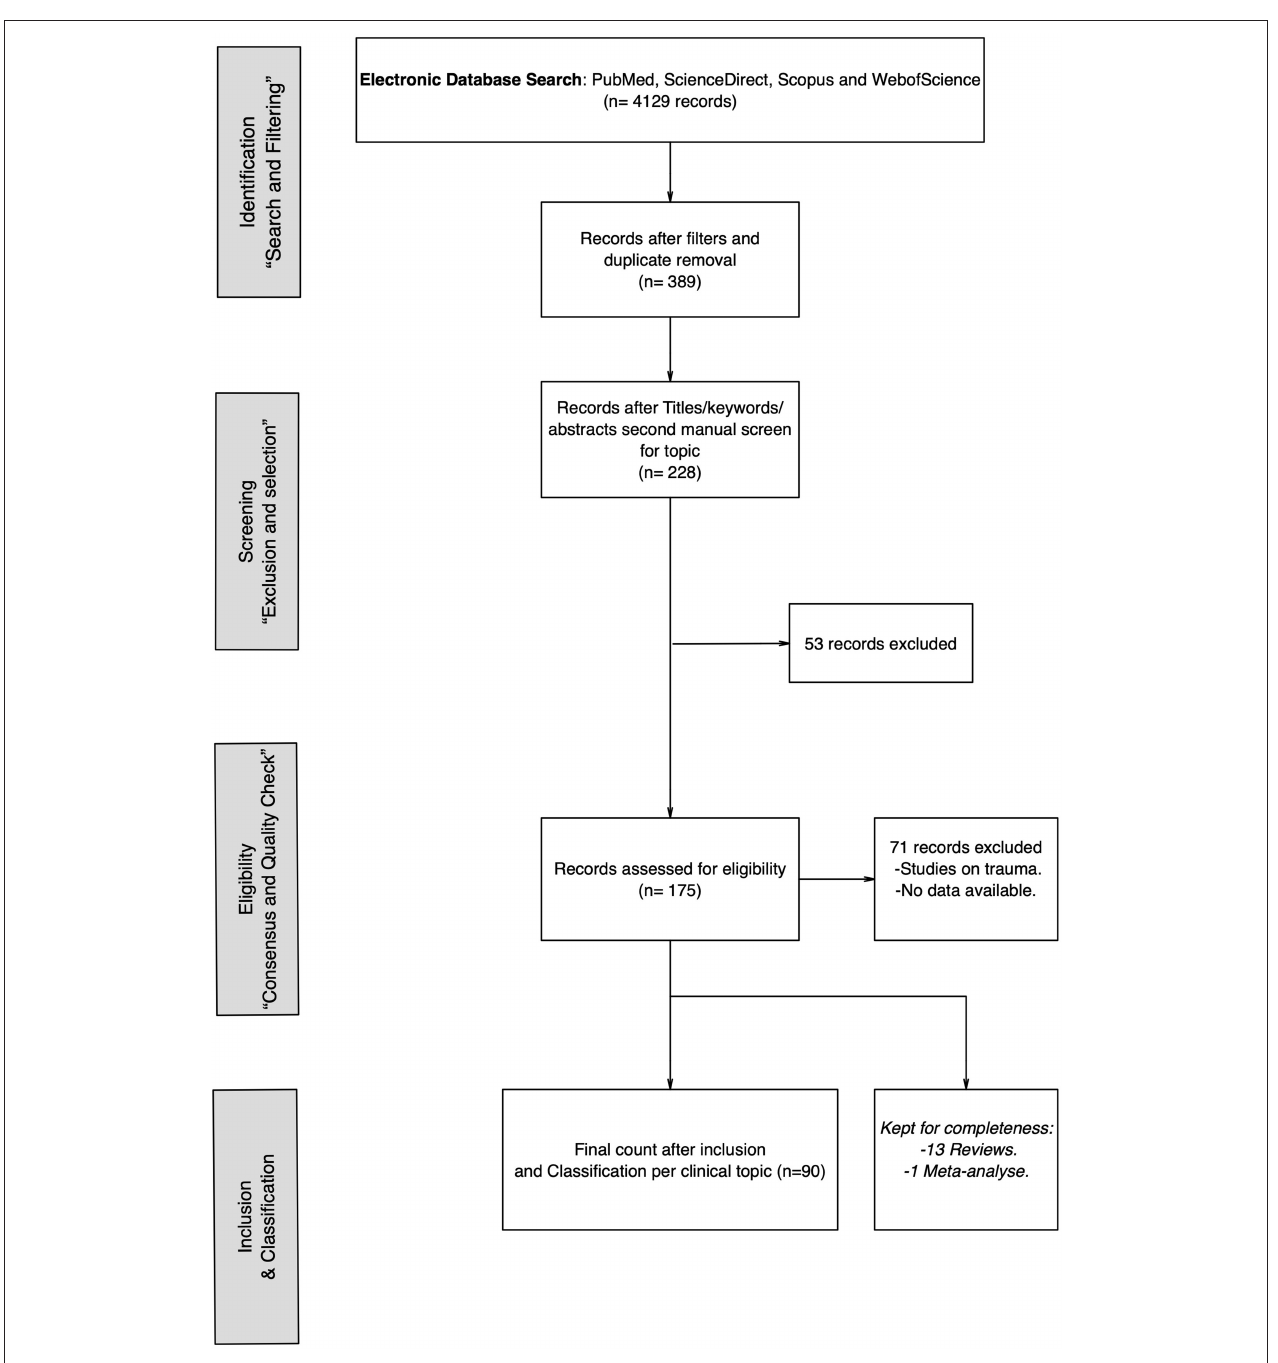
FIGURE 1 | Flowchart depicting the search, selection, and inclusion of the items of the systematic